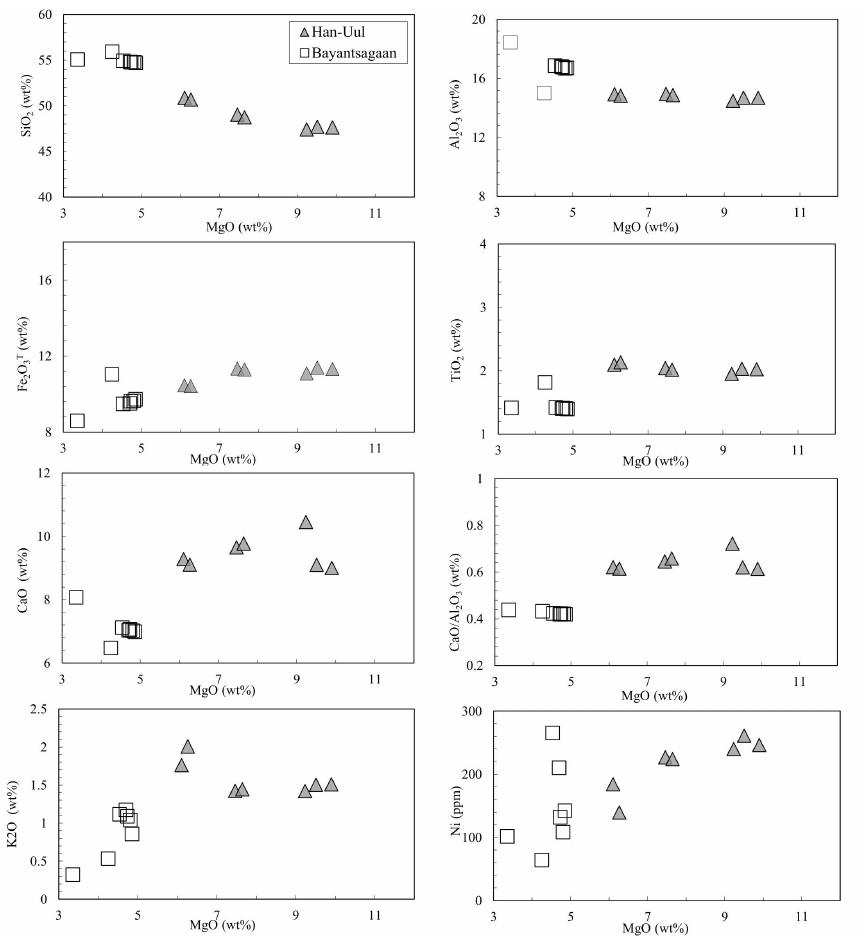
Fig. 5. Oxides, CaO/Al O , and trace elements Ni versus MgO plots for the basalts from 2 3 the Bayantsagaan and Han-Uul volcanic provinces from the Bayantsagaan and Han- Uul volcanic provinces